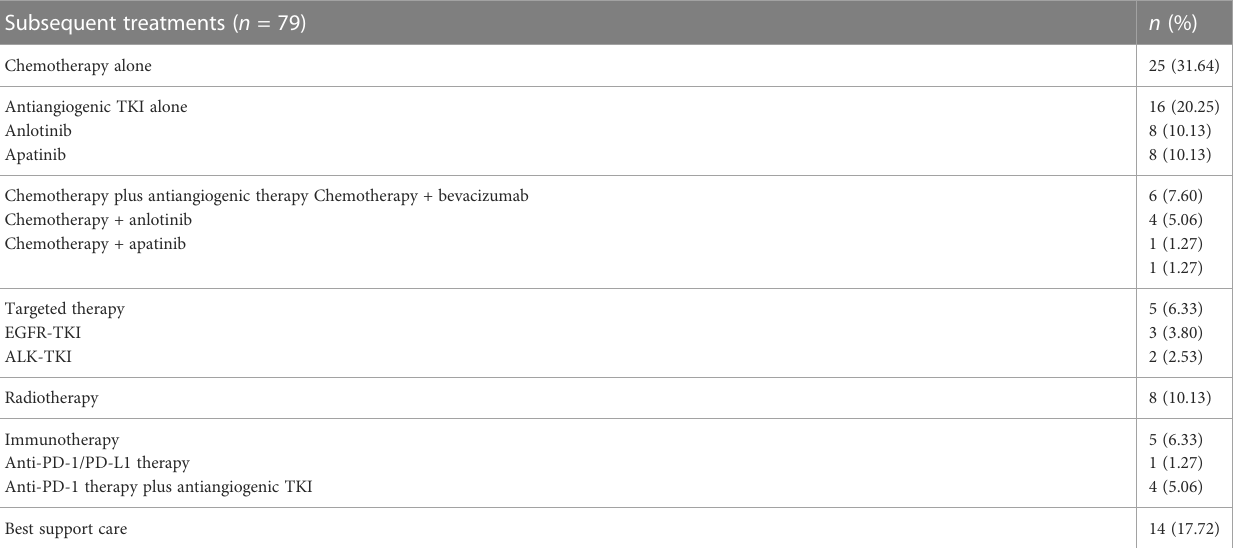
TABLE 5 Subsequent treatments after second-line therapy.